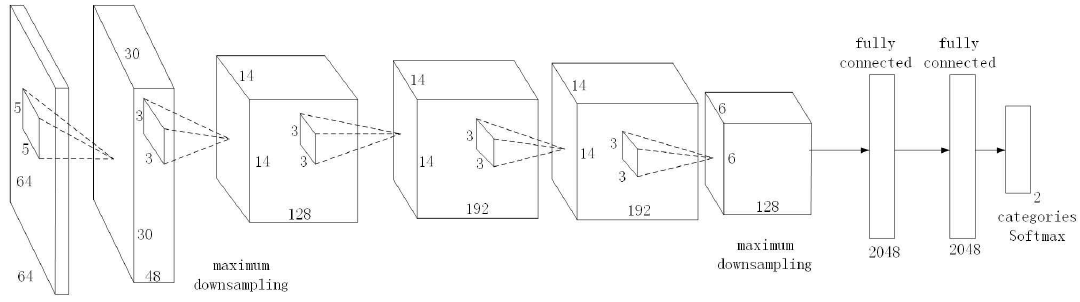
Figure 14. objNet network structure. Table 4. The parameters of each layer in objNet